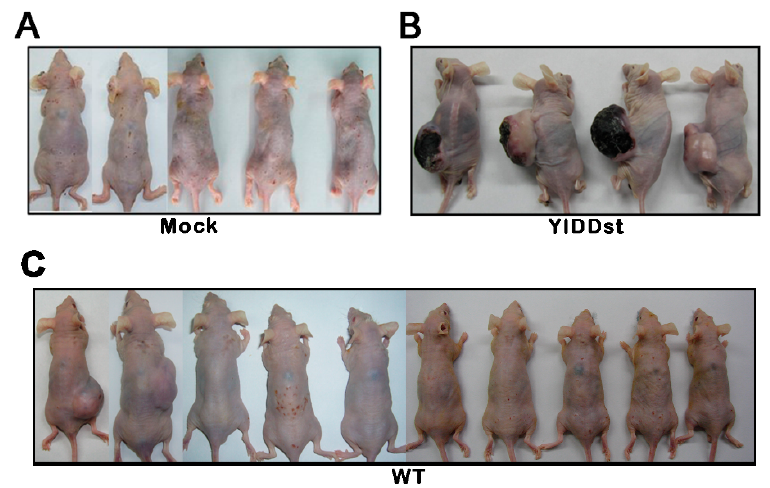
Figure 4. Mouse xenograft tumorigenesis. 1 × 10 6 cells were injected subcutaneously and observed for 15 weeks. ( A ) pIRESmock-transfected cells, ( B ) pIRES-YIDDst cells, and ( C ) pIRES-WT cells.